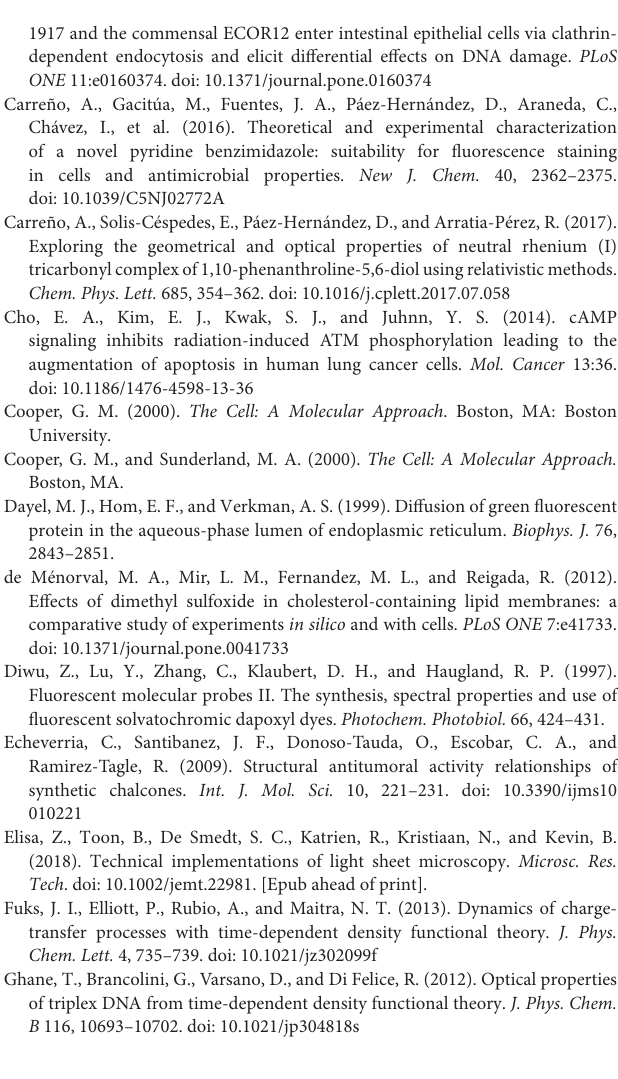
Figure S2 | FTIR (ATR) of precursor (phenyl-3,5-di-tert-butyl-2-hydroxybenzoate). Figure S3 | FTIR (ATR) of B2 . Figure S4 | Numbering protons of B2 . Figure S5 | Aromatic zone of the 1 HNMR spectrum of B2 . Figure S6 | 1D TOCSY of B2 (in DMSO- d6 ), irradiating H3 at 3,597Hz (8.99 ppm). Figure S7 | 1D TOCSY of B2 (in DMSO- d6 ), irradiating H4 at 3,208Hz (8.02 ppm). Figure S8 | 1D TOCSY of B2 (in DMSO- d6 ), irradiating -OH at 5,451Hz (13.62 ppm).